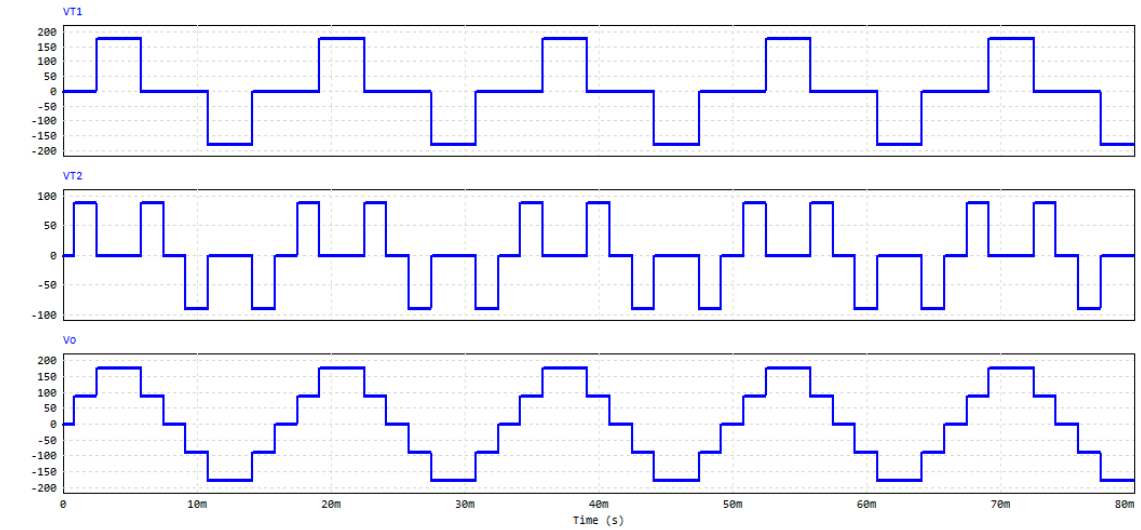
Figure 24. Voltages at transformers ’ output and the output voltage.